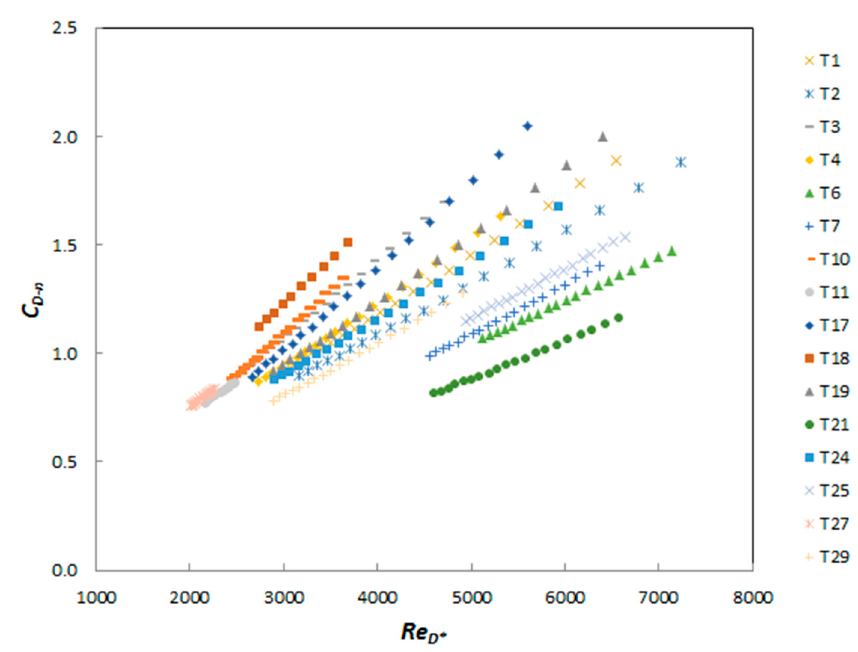
Figure 8. Drag coefficients C D − n computed by means of the best Manning coefficient versus Re D ∗ for 16 experiments.